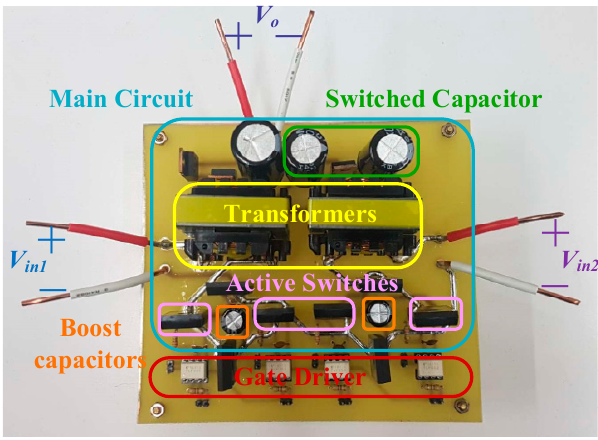
Figure 20. Measured converter efficiency while only input port 2 powers the DHSIC.